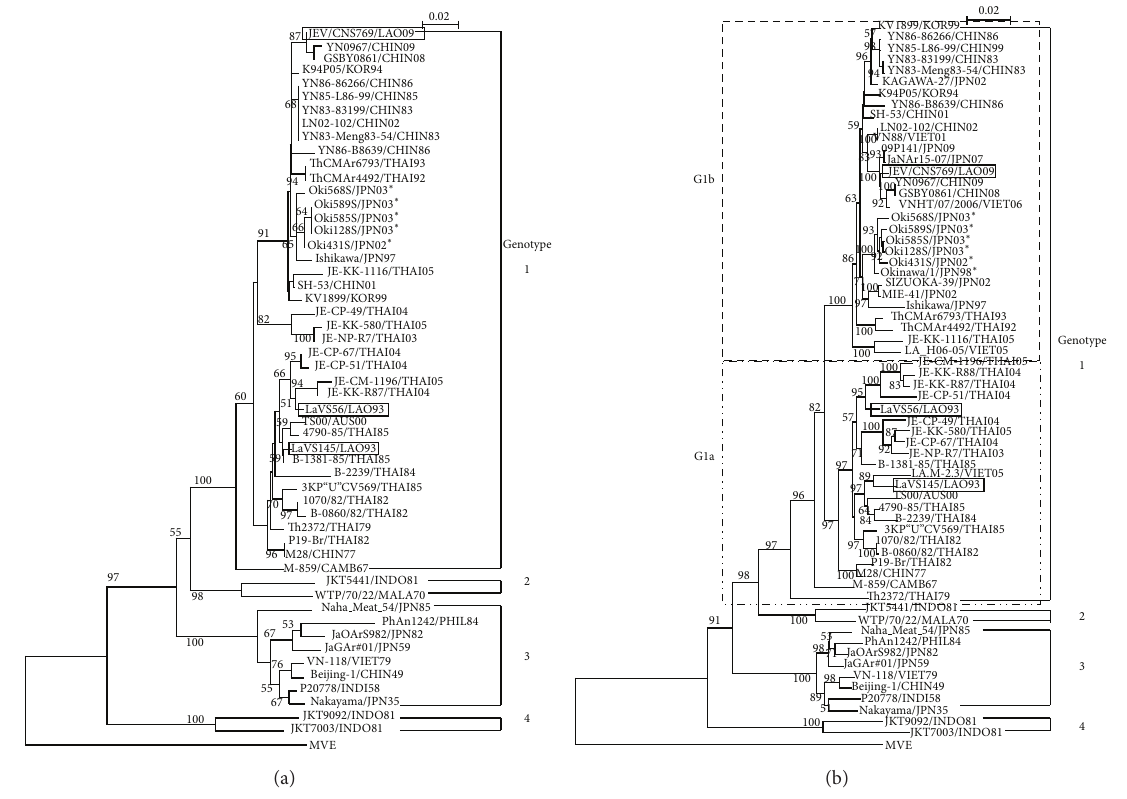
Figure 1: Phylogenetic analysis of JEV strains, with the Murray Valley encephalitis virus strain MVE 1–51 (GenBank accession number NC-000943) as an outgroup. (a) Tree based on a 240-nucleotide sequence of the core-premembrane gene region. (b) Tree based on a 1500- nucleotide sequence of the envelope gene region. Vientiane isolates are indicated in the box, and Okinawan isolates are indicated as ∗ . G1a subcluster and G1b subcluster of JEV genotype 1, indicated in the dot line box, according to Nitpattana and others